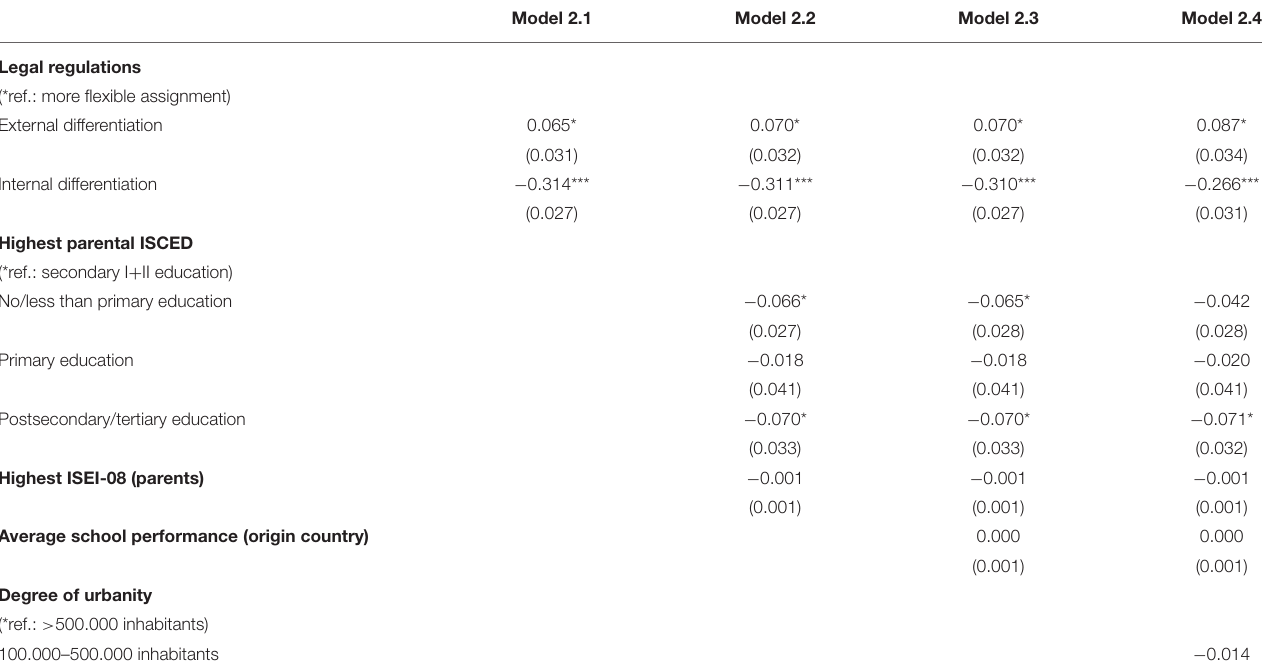
TABLE 7 | Stepwise linear probability models on attending a newcomer class as dependent variable (regular class vs. newcomer